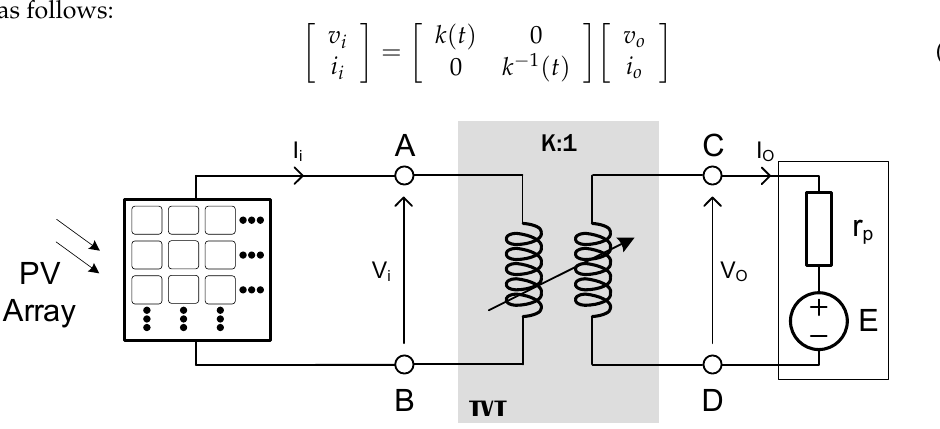
Figure 8. PV array–load coupling by means of controlled transformer.